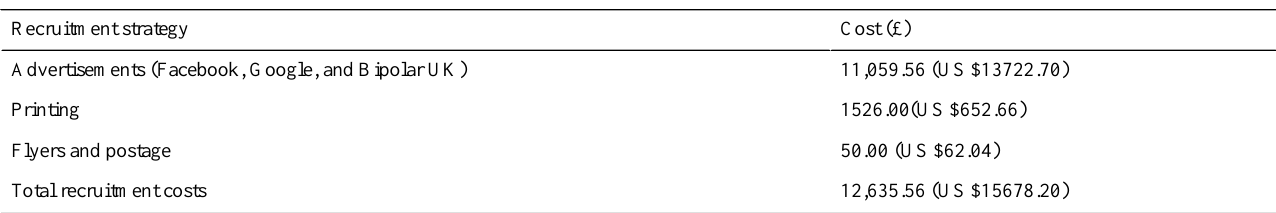
Table 2. Recruitment